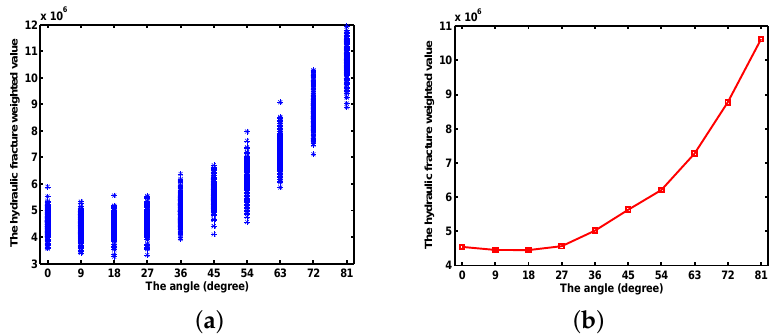
Figure 15. The influence of dip angle ( α ) on the hydraulic fracture weighted value when the angle between two groups of fracture are 20 ◦ . Here, n = 250 and l = 0.2 m. Ten kinds of α (0 ◦ ,9 ◦ ,18 ◦ ,27 ◦ ,36 ◦ ,45 ◦ ,54 ◦ , 63 ◦ ,72 ◦ and 81 ◦ ) were simulated, with 150 groups of fractures randomly generated for each kind of α . ( a ) scatter distribution of the hydraulic fracture weighted value with different values of α ; ( b ) average of the hydraulic fracture weighted value with different values of α